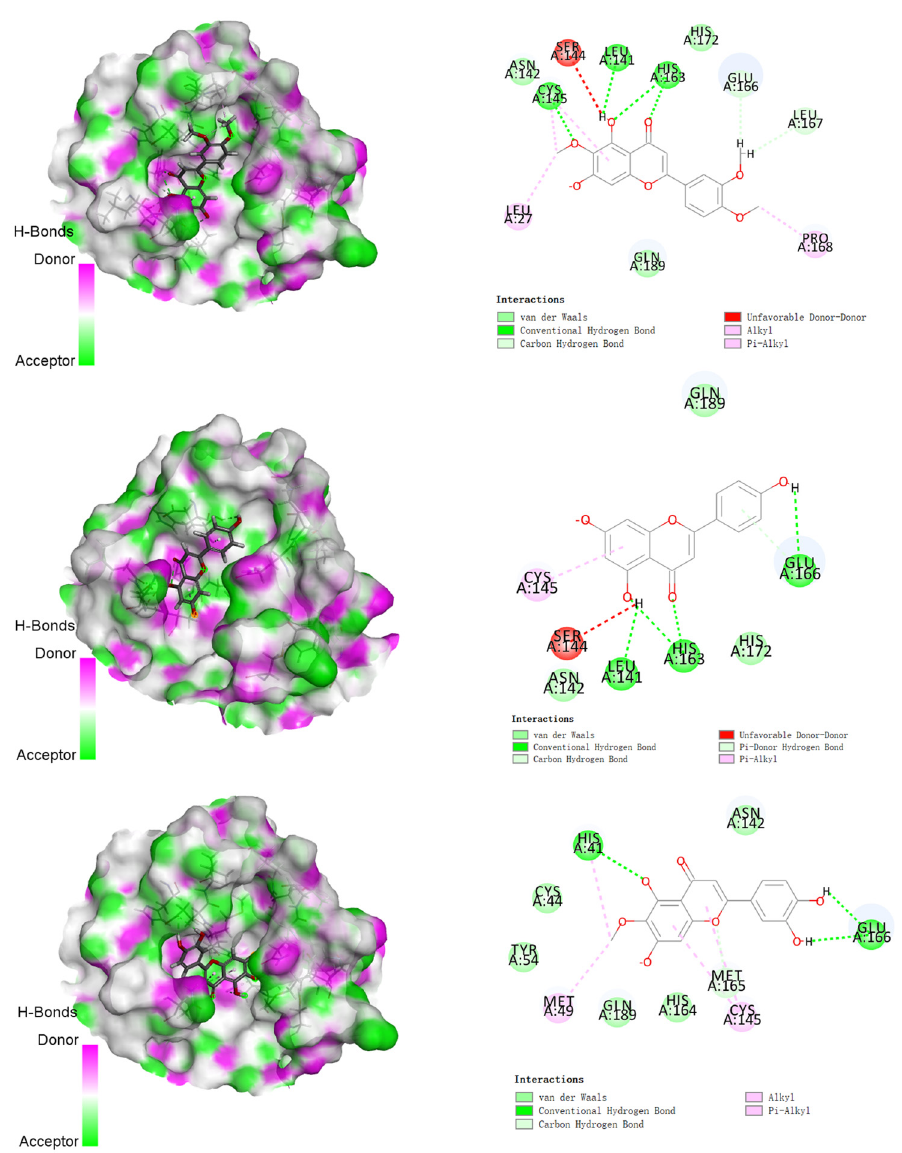
Figure 5. The binding mode of compound 2 – 4 (3D view and 2D view) with 2019-nCoV protease. The carbon atoms of compound 5 and 2019-nCoV protease were represented as grey sticks, and oxygen atoms were shown in red. All the nonbonded interactions are shown in dotted lines with different colors according to their different interaction